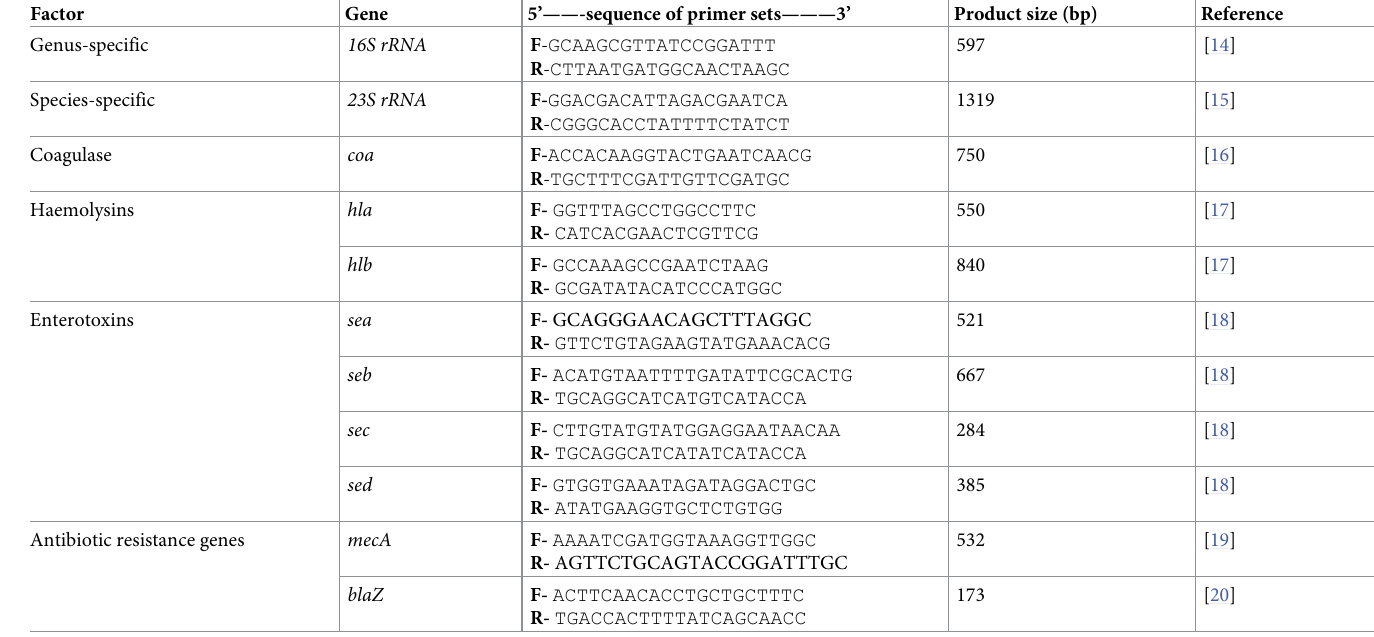
Table 1. Oligonucleotide primers used in the study. Factor Gene 5’——-sequence of primer sets———3’ Product size